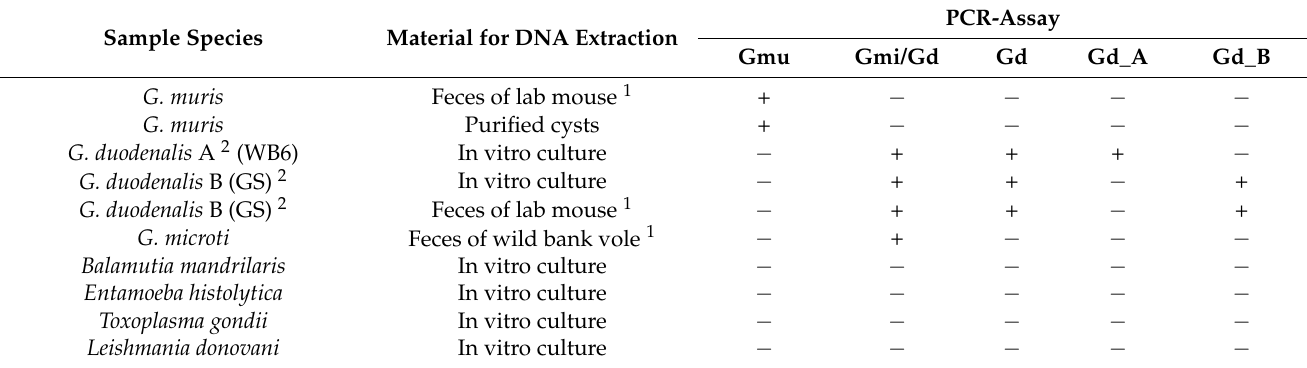
Figure 2. Workflow of the real-time PCR approach used to determine G. muris , G. microti and zoonotic G duodenalis in rodent samples. Table 2. Specifics of the